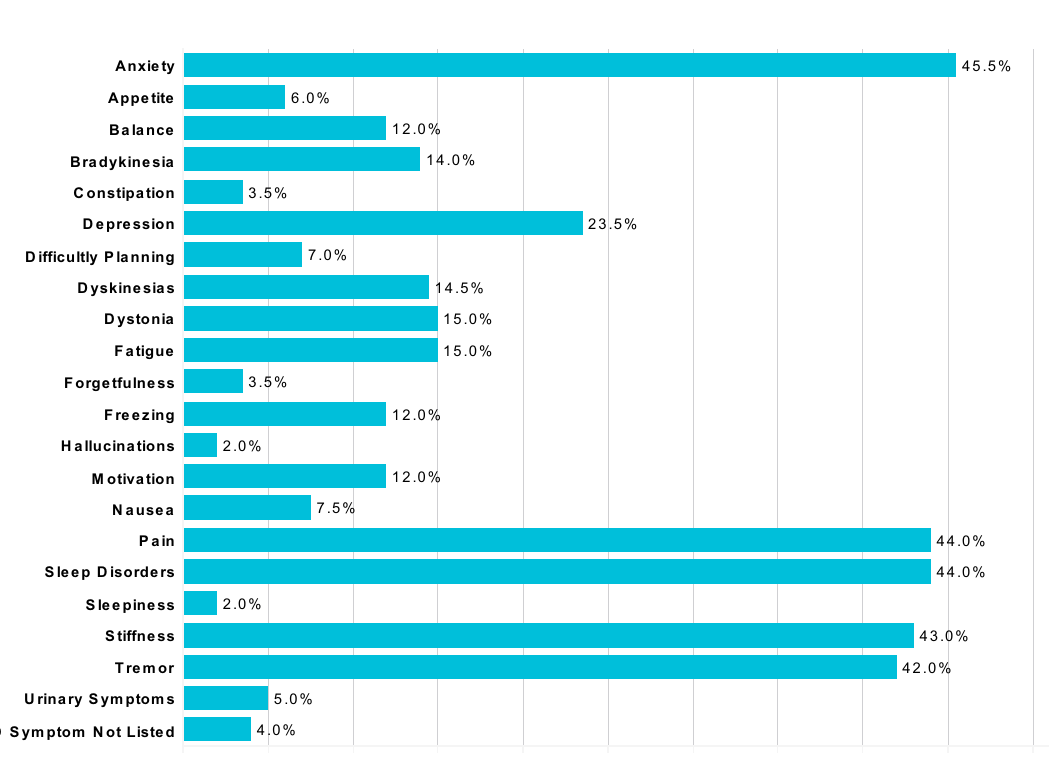
Fig. 4 Cannabis use for selected PD symptoms. Users that indicated cannabis use for speci fi c or general PD symptoms ( n = 200) were asked, “ For which of the following symptoms do you use marijuana or cannabis to improve? ”